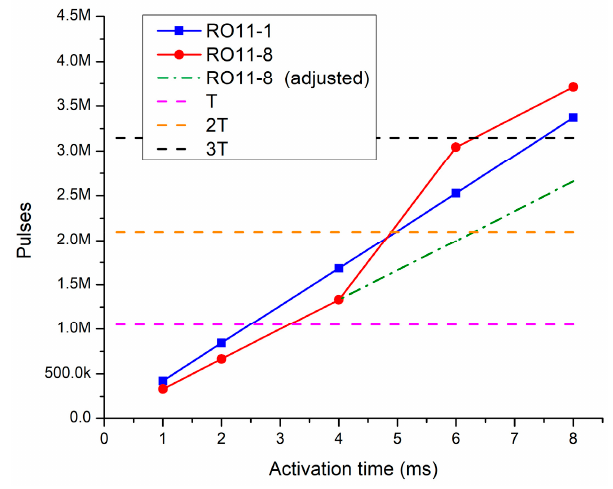
Figure 9. The plot of adjusted pulses versus runtimes of RO5 using Pattern-1 in chip-10. As shown in Figure 9, a nonlinear trend (RO5-8) exists, shown in the red line starting at 4 ms, suggesting that pulses fell outside the green areas at 6 and 8 ms. In addition, this line indicates that pulses fell on the counting edge (a gray area), as shown in Figure 6. Although we chose the runtime selectively, the pulses might have approached the counting edge due to differences in delay among chips and the influence of temperature. Since the pulses generated by chain RO5-8 did not exceed 2 × 2 20 (at 6 ms) and 3 × 2 20 (at 8 ms), totals of pulses were increased by 1 × 2 20 (at 6 ms) and 2 × 2 20 (at 8 ms). Then the linear line was retrieved, as shown by the dash-dot line